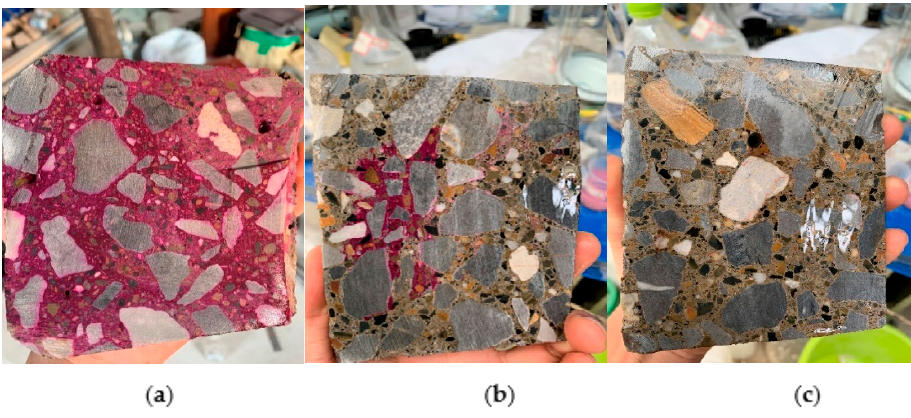
Figure 3. Phenolphthalein indicator shows changes in solution: ( a ) 0 h; ( b ) 1 h; ( c ) 2